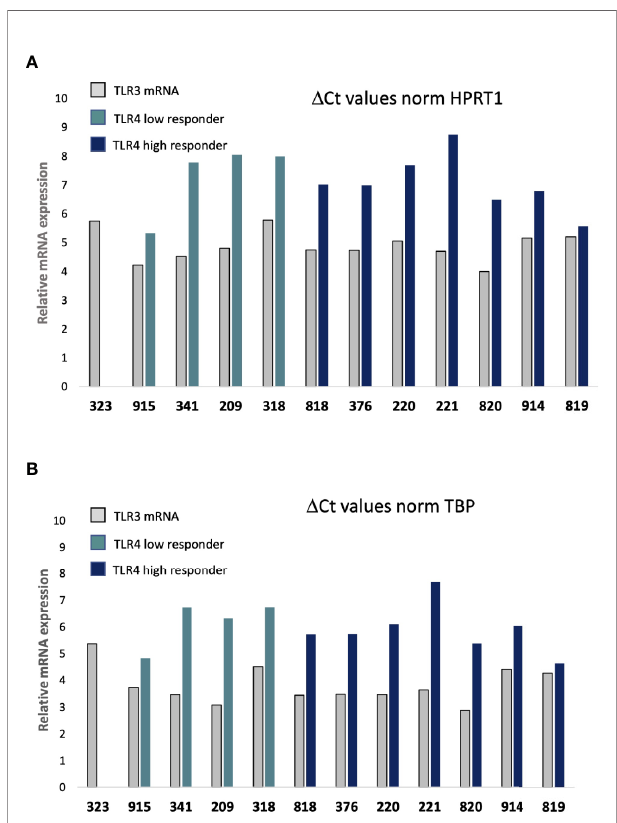
FIGURE 5 | Quantitative real time PCR (qRT-PCR) analysis of TLR3 and TLR4 mRNA expression. Delta Ct (cycle of threshold) values of samples at dilution 1:5 are normalized to HPRT1 gene (A) or TBP (B) internal control genes expression within the same cDNA sample at dilution 1:5. Open bar: TLR3; Light blue bar: TLR4 in “ low ” responder cells; Dark blue bar: TLR4 in “ high ” responder cells. 209, 220, 221, correspond to women age 30 – 39; 318, 323, 341, 376 to men age 30 – 39; 818, 819, 820 to women age 60 – 69; and 914, 915: men age 60 –